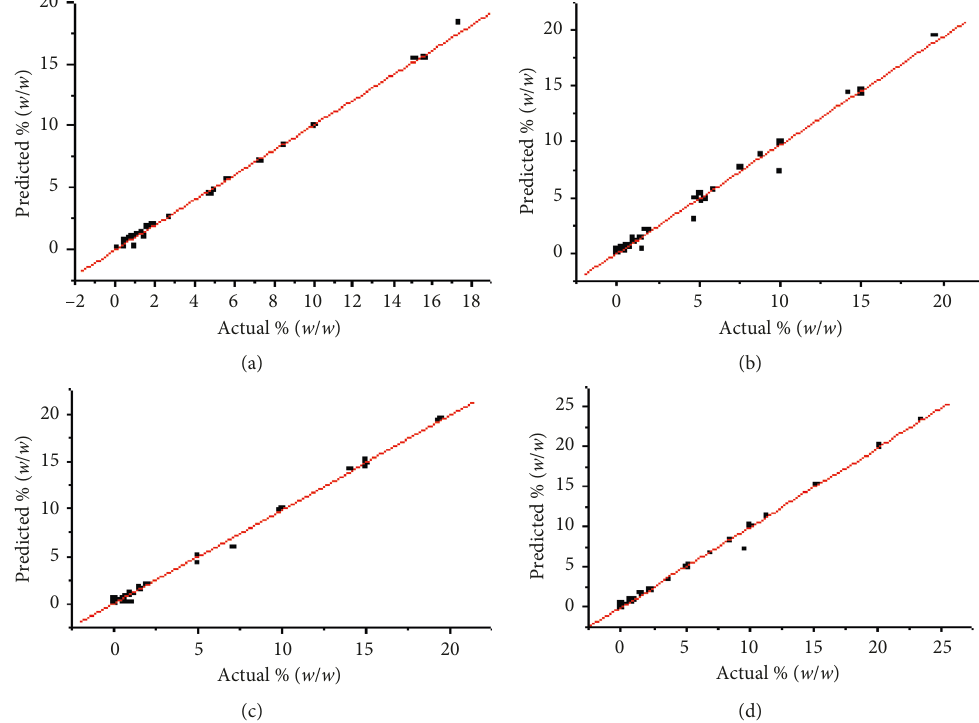
Figure 3: Correlation statistics between actual and predicted values for fructose (a), glucose (b), maltose (c), and sucrose (d).